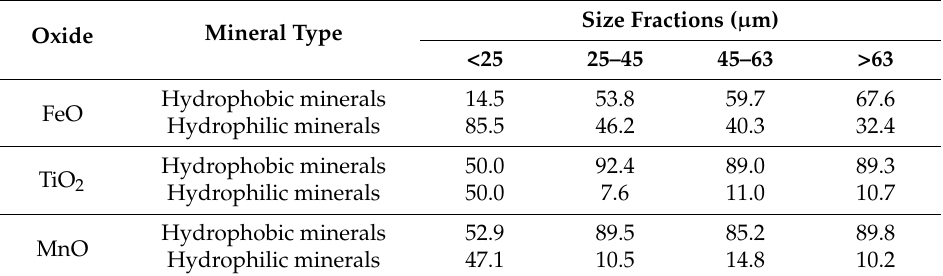
Table 3. Distribution of FeO, TiO 2 , and MnO (%) in hydrophobic and hydrophilic minerals. Oxide